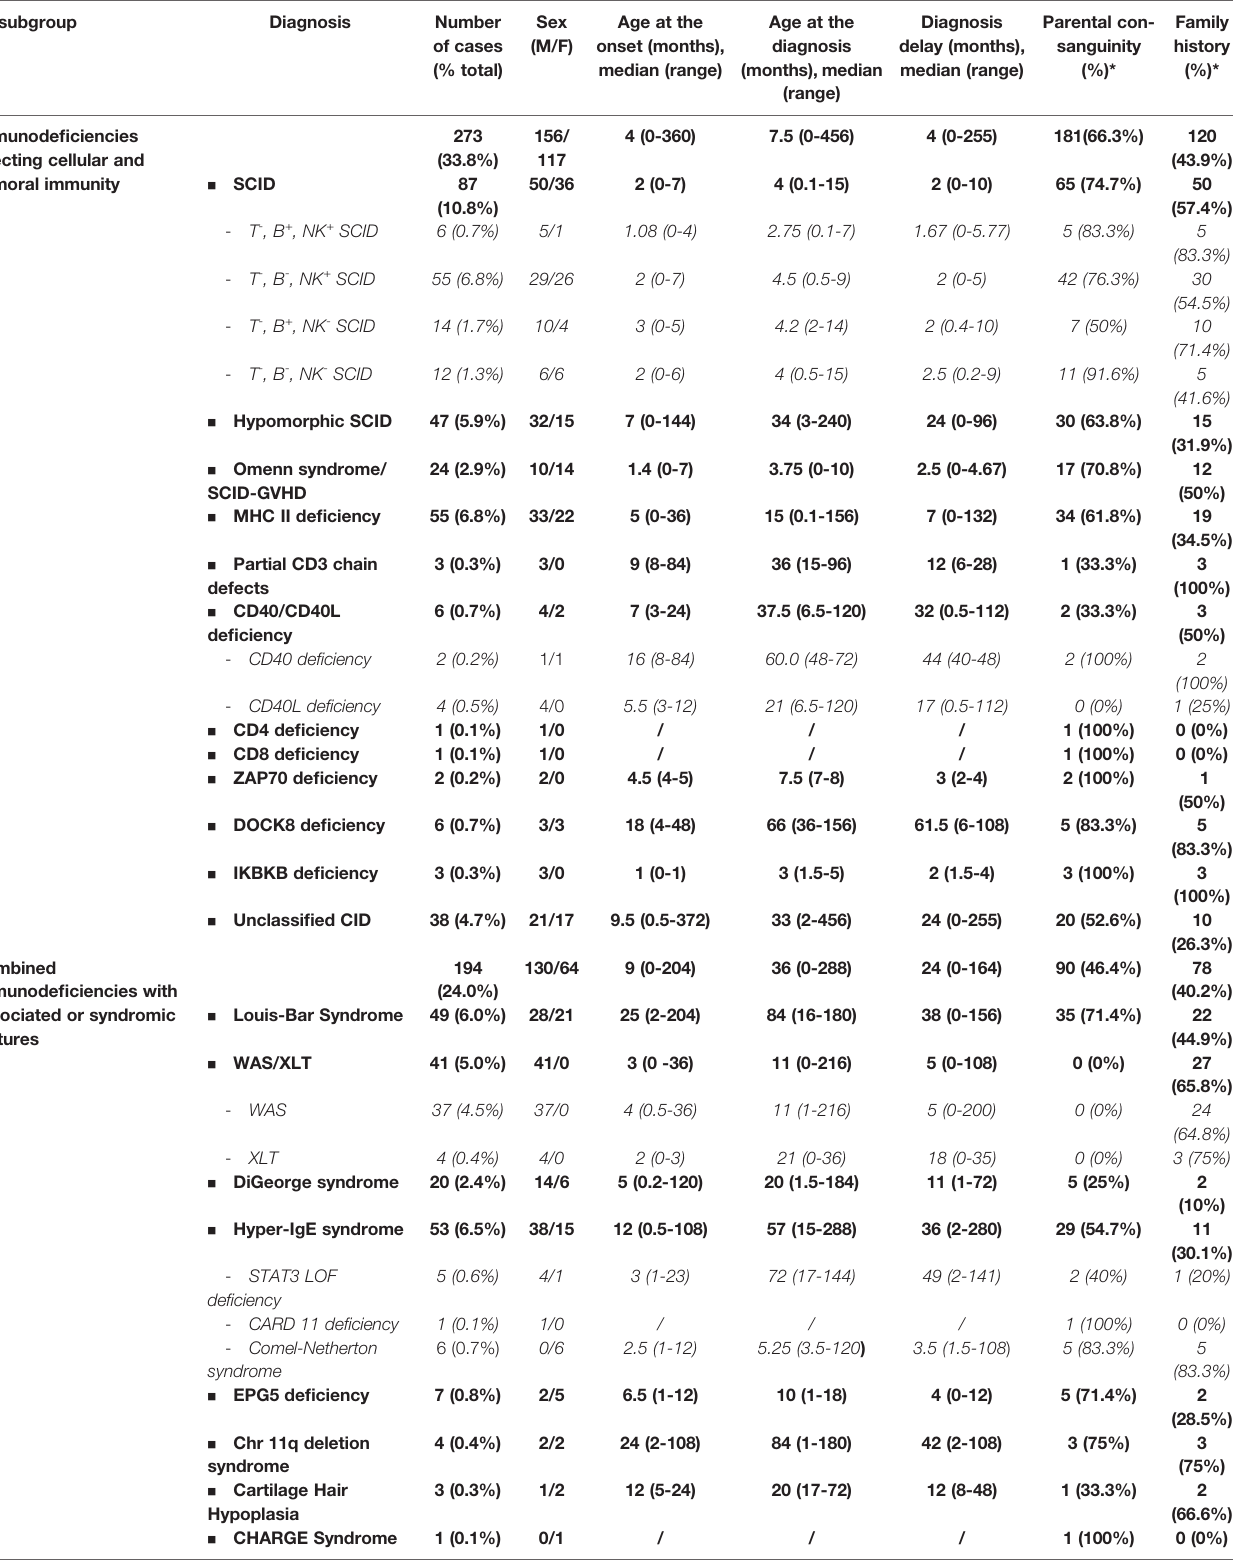
TABLE 1 | General characteristics of patients with different phenotypes of inborn error of